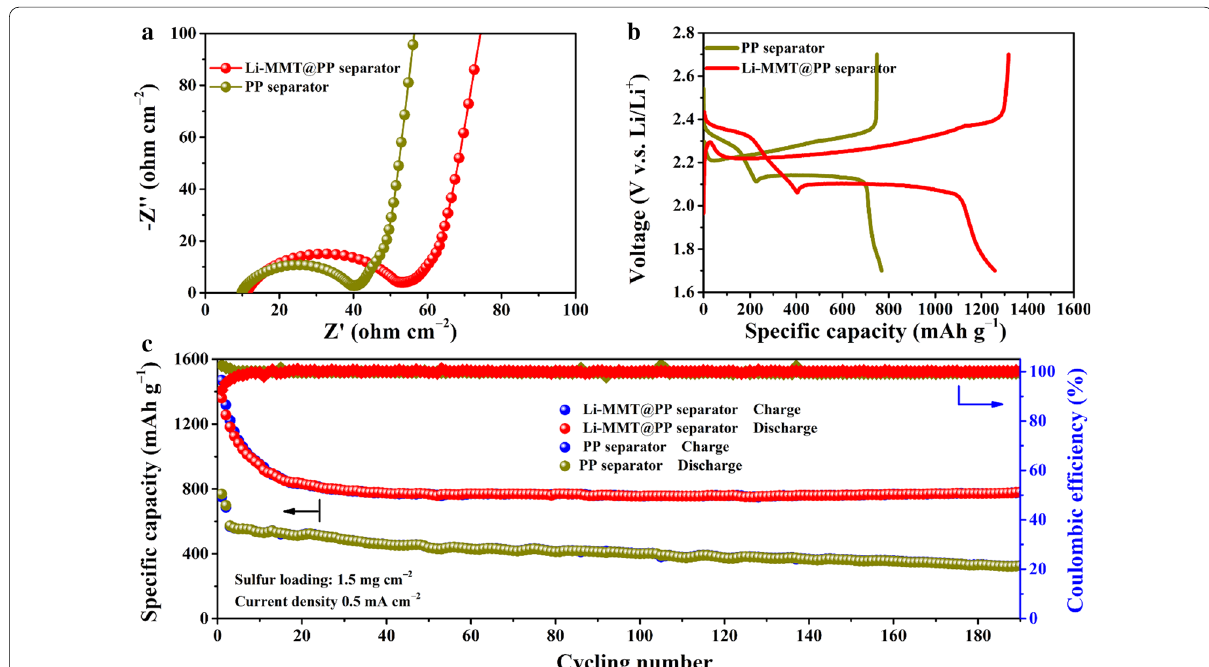
Fig. 4 Electrochemical performance of Li–S batteries with different separator. a EIS results. b The charge/discharge plateaus with Li-MMT@PP or PP separator. c Long-term cycling performance at 0.5 mA cm − 2 with sulfur loading of 1.5 mg cm −